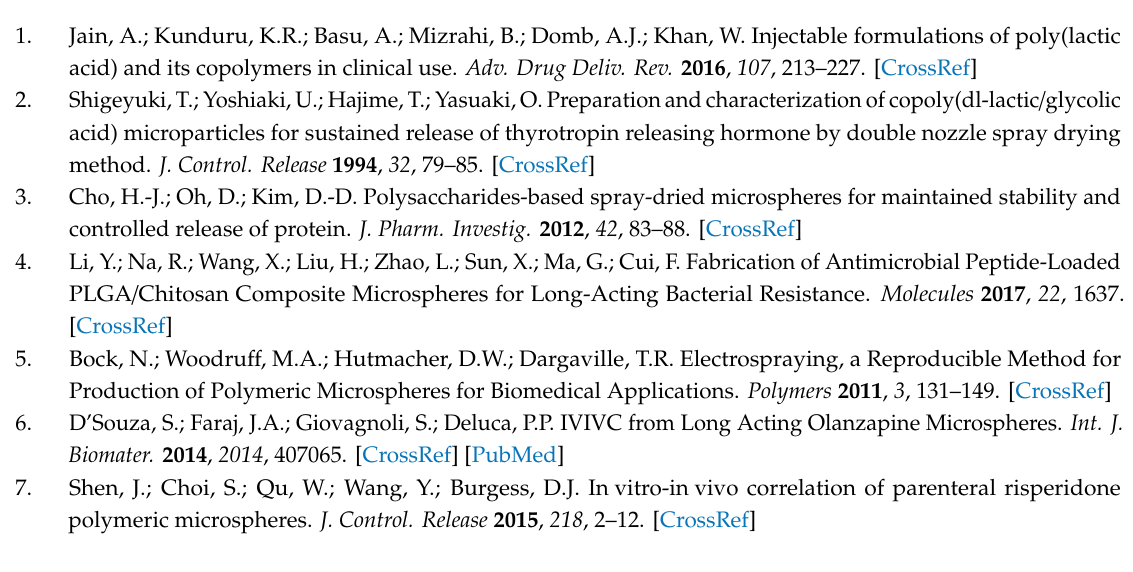
Figure S1: The observed in vitro release profiles and the predicted in vivo release profiles of OL1 (A), OL2 (B), OL3 (C), OL4 (D), and OL5 (E), Table S1: Composition of trial formulations and conditions of electrospraying, Table S2: Test results of solvents for the polymer phase, Table S3: Test results of solvents for the drug phase, Table S4: Mixing ratio of polymer and drug